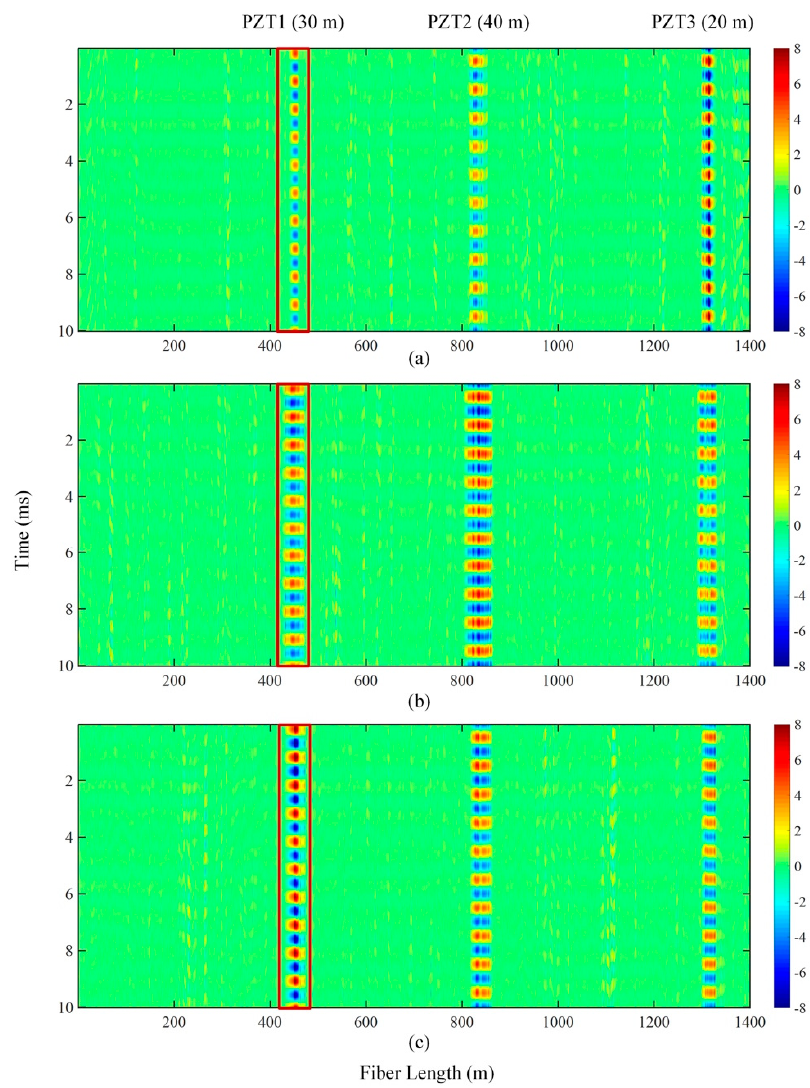
Figure 6. The waterfall plot of Φ -OTDR phase angle for three beat signals. ( a ) 110 MHz; ( b ) 70 MHz; ( c ) 40 MHz.